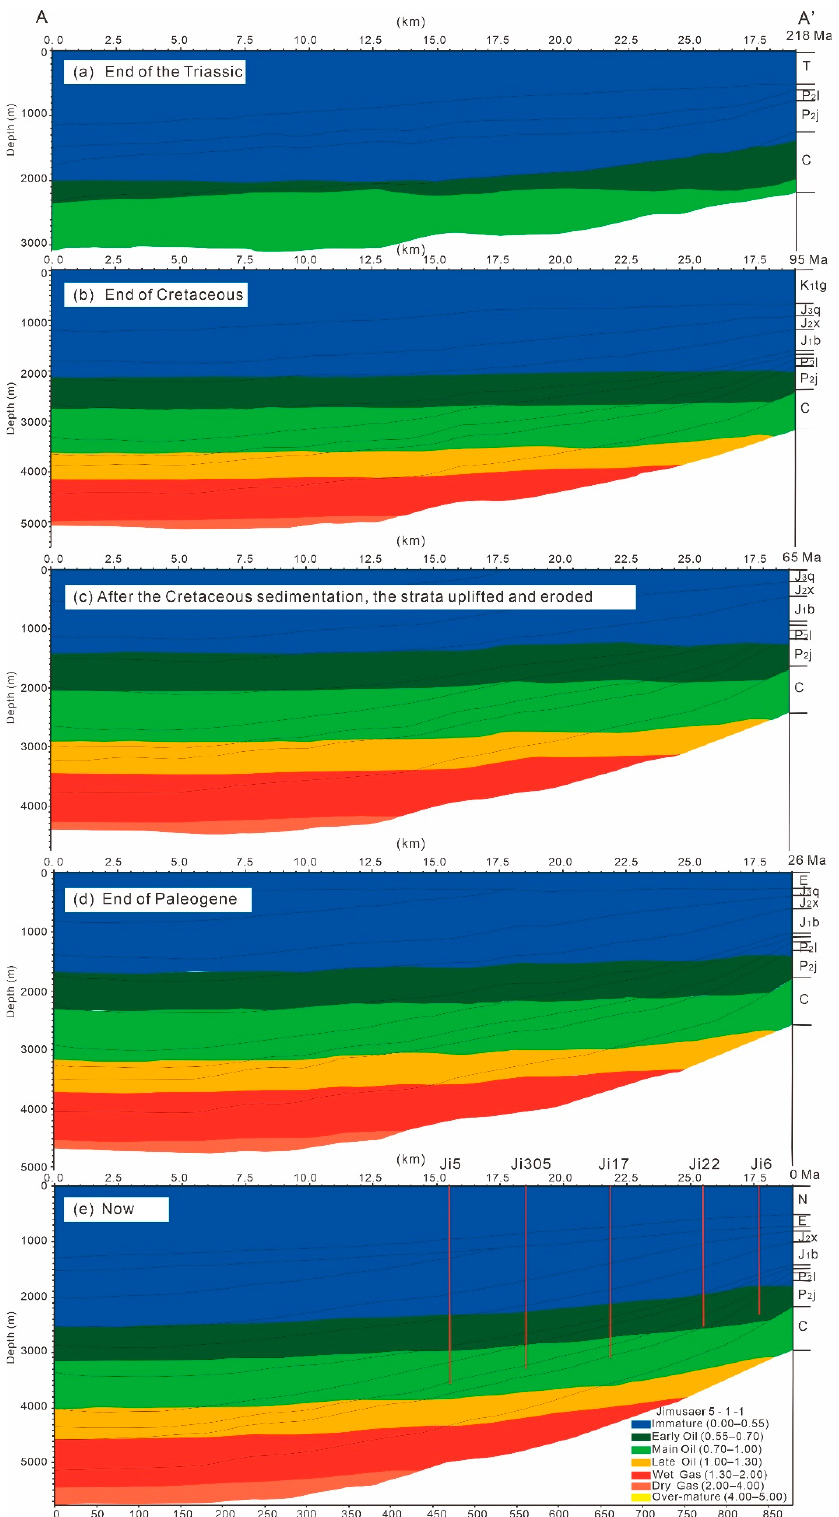
Figure 9. Two-dimensional simulation profile of the thermal evolution and burial history of the P 2 l source rocks in the Jimsar Depression (Late Triassic ( a ); Late Cretaceous ( b ); after Cretaceous deposition, uplift and denudation of formations ( c ); Late Paleogene ( d ); present day( e )). The location of this section can be found in Figure 1c.